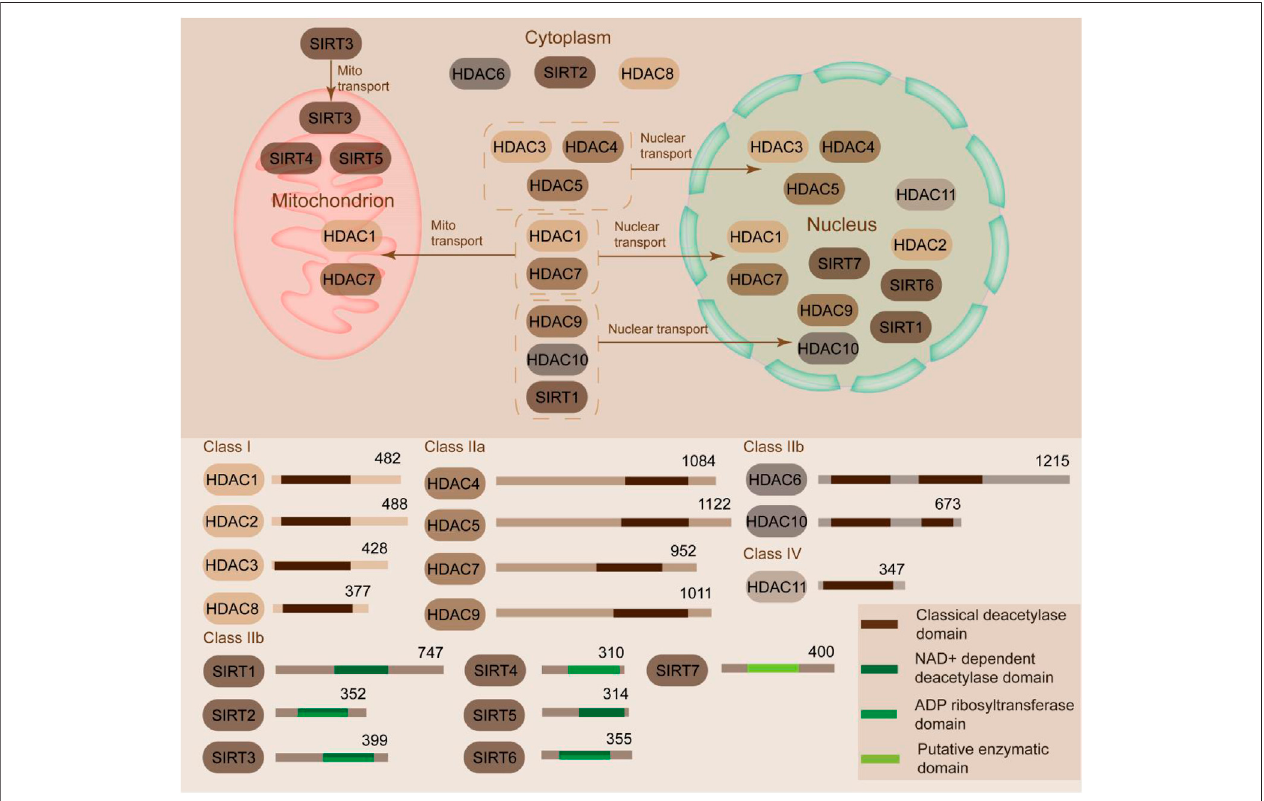
FIGURE1| Classi fi cationand sublocationofHDACs.HDACscanbeclassi fi edintoClass I,II,III,and IVaccordingtosimilarities. ClassIHDACs(HDAC1/2/3/8) are mostly located in the nucleus. Class II HDACs are subclassi fi ed into subclass IIa (HDAC4, 5, 7 and 9) and subclass IIb (HDAC6 and 10). Class IIa HDACs translocate between cytoplasm and nucleus. Class IIb members mostly localize in the cytoplasm. Class III contains seven members (SIRT1 to 7). SIRT1/2 shuttle between the nucleus and cytoplasm. SIRT6/7 are mostly in the nucleus. SIRT3/4/5 are localized in the mitochondria. Class IV HDAC (HDAC11) is predominantly located in the